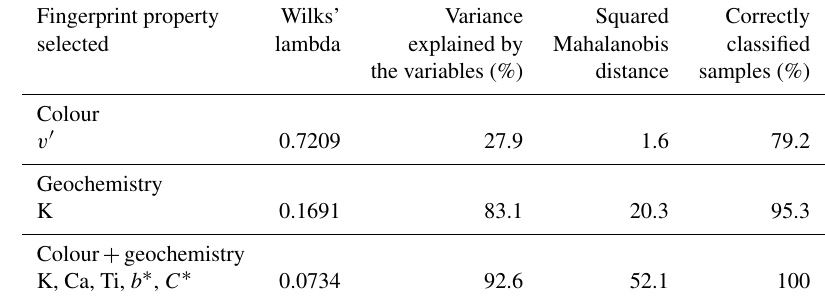
Table 3. Results of DFA used to identify the optimum tracer combination to differentiate sources supplying sediment to the Thio River.